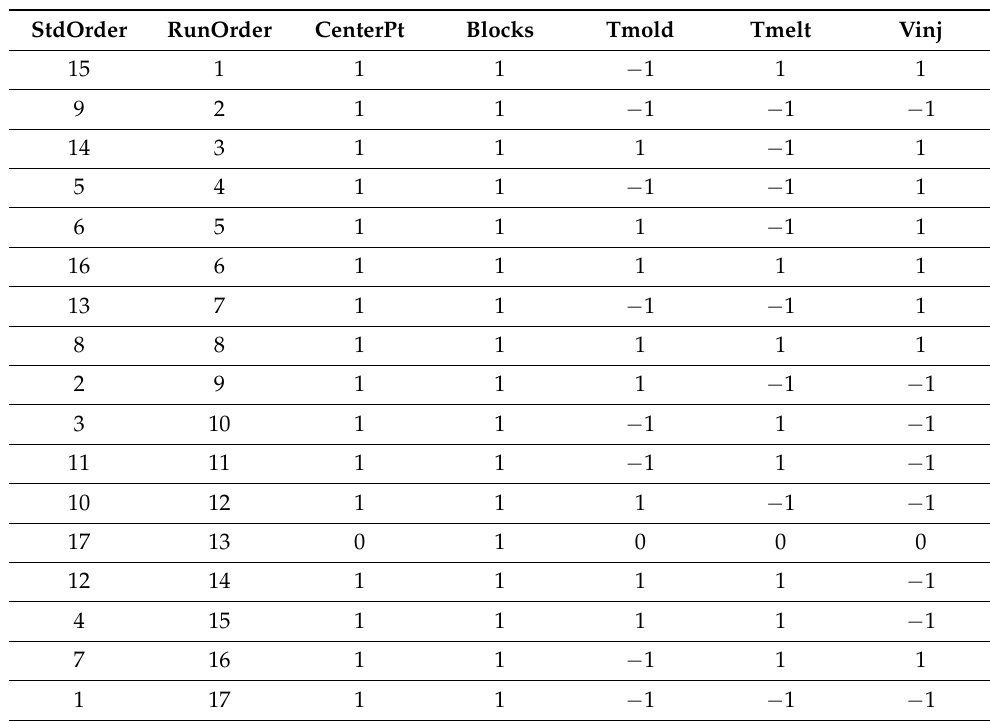
Table 5. Experimental treatments and run